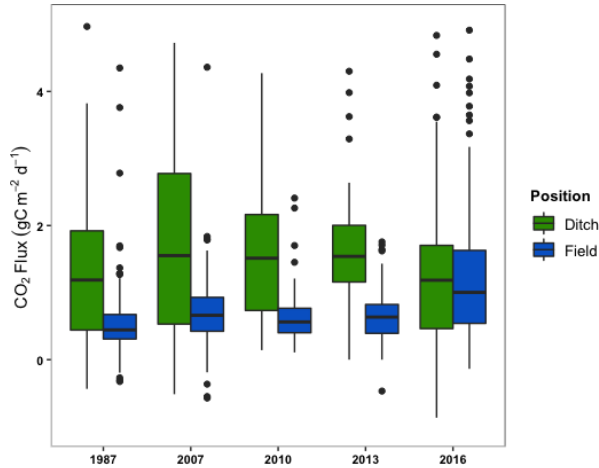
Figure 4. The box and whisker plots (median, upper and lower quar- tiles, and outliers) of CO 2 fluxes from the drainage ditch and the three field locations combined (2, 5, and 15m) by the year a sector was opened.